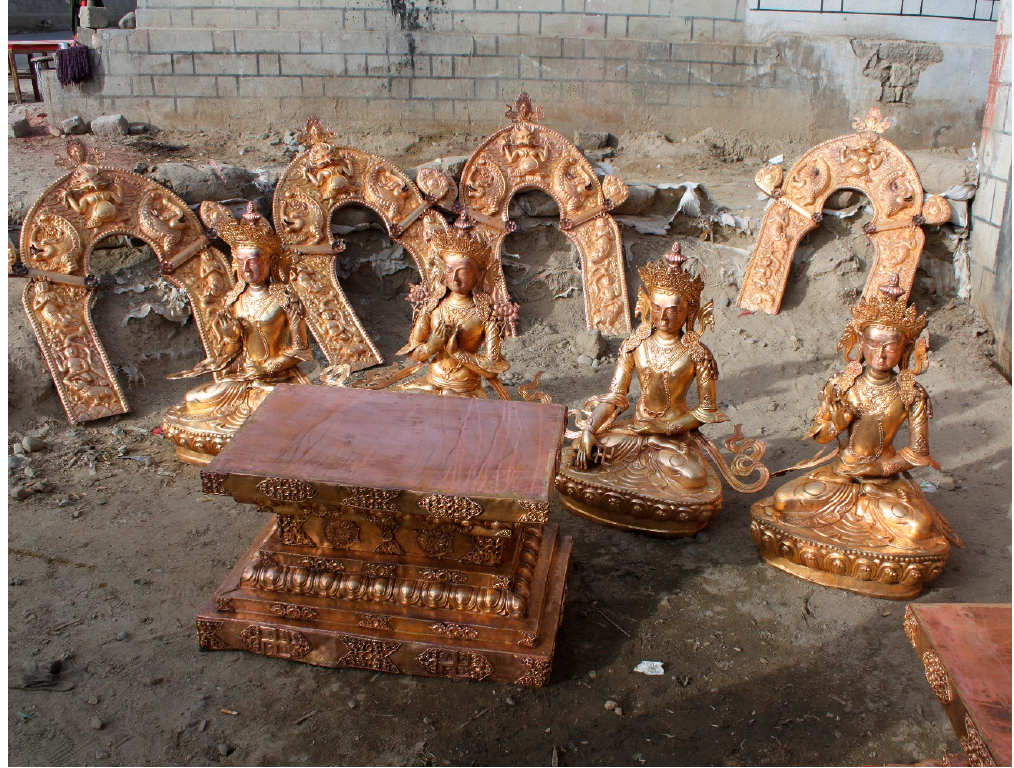
Figure 4. Unfinished metal statues in a Buddhist art workshop near Sera Monastery, Lhasa, Tibet (photo Bellini